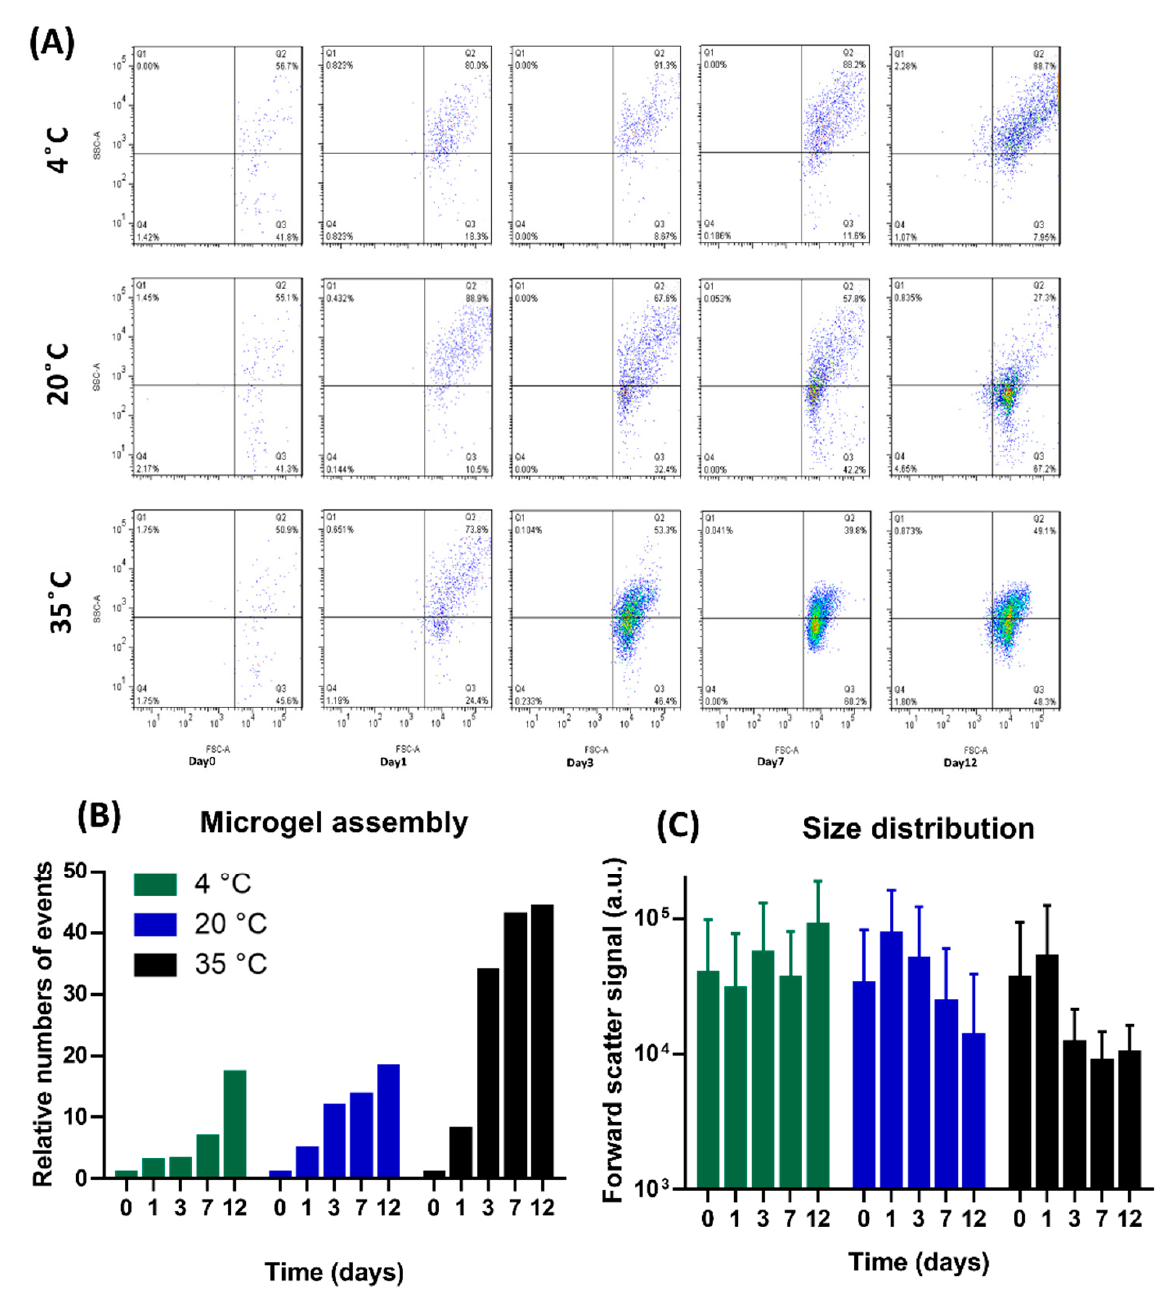
Figure 1. Effects of temperature on microgel assembly and size. ( A ) The microgel particle distributions in the effluent at different temperatures (4 ◦ C, 20 ◦ C, and 35 ◦ C) were measured by flow cytometry. The X -axis represents forward scatter signal, and the Y -axis represents side scatter signal. The Q1 to Q4 grouping was determined by a gating strategy, and the associated numbers represent the relative population percentage. The line on the X -axis is defined as >0.5 µ m of the particle boundary. ( B ) The relative microgel assembly numbers were calculated from the flow data. Each relative number was divided by the number of events at different temperatures on day 0. ( C ) The microgel size distribution was determined from the forward scatter signal. Each column represents mean ± SEM of forward scatter signals in the flow